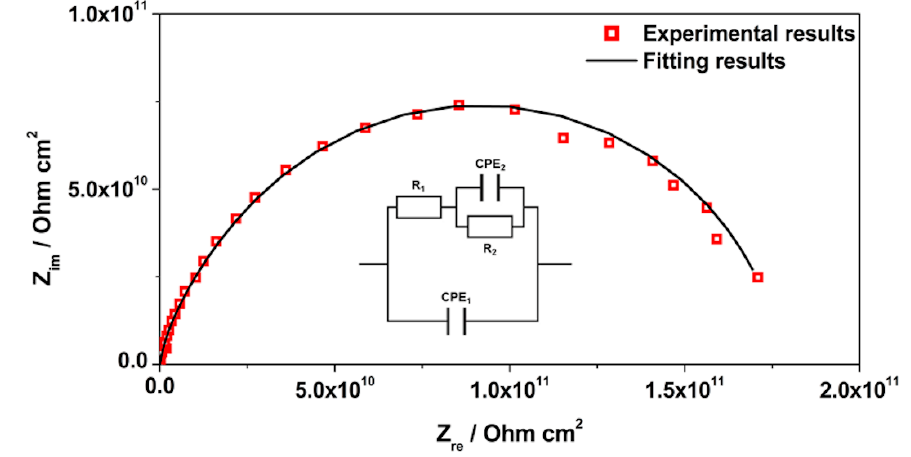
Figure 5. Nyquist plot for pure OIH AES(800)-1/2.